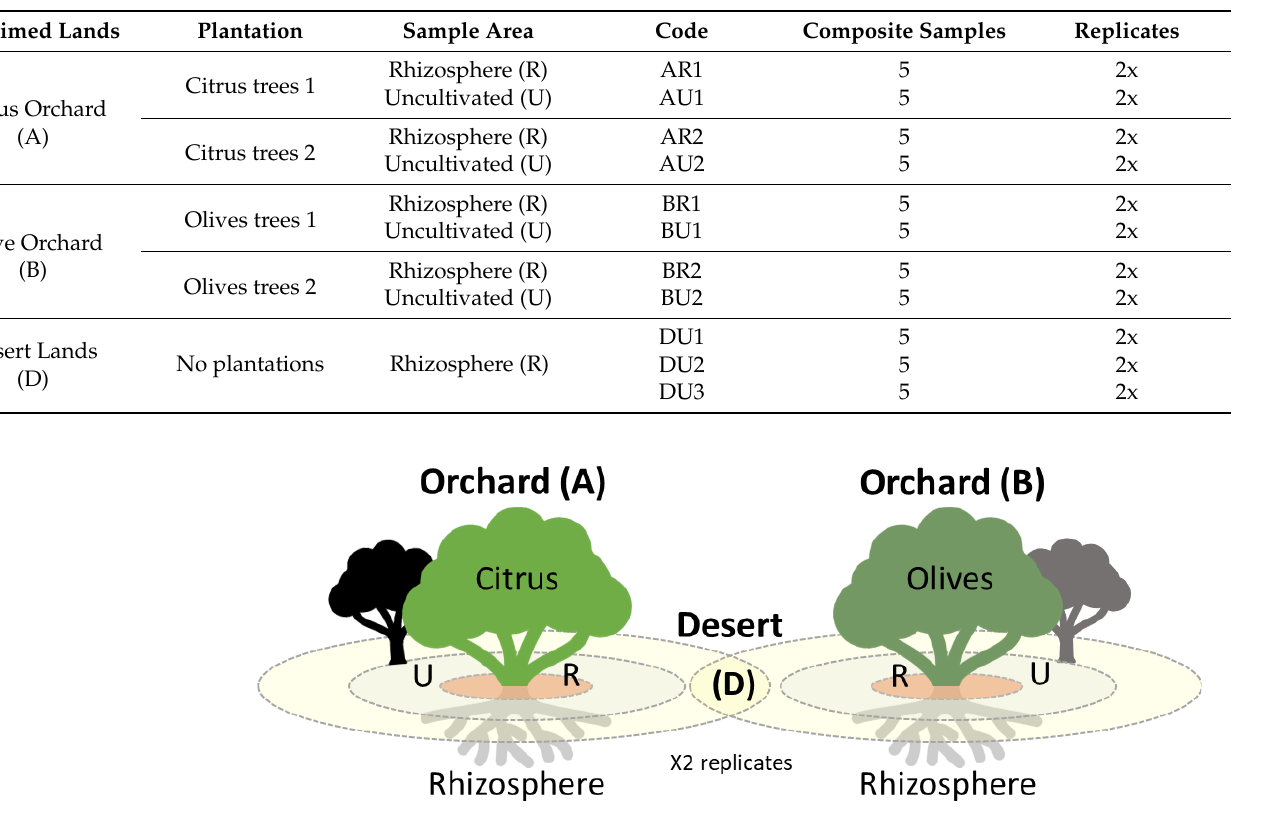
Figure 1. Graph illustrating sample selection from land types, both reclaimed, and desert lands. Each land type was sampled beneath the plant trunk (i.e., rhizosphere; R) and from the uncultivated area (U) between trees. All samples were collected at the same depth in duplicates.